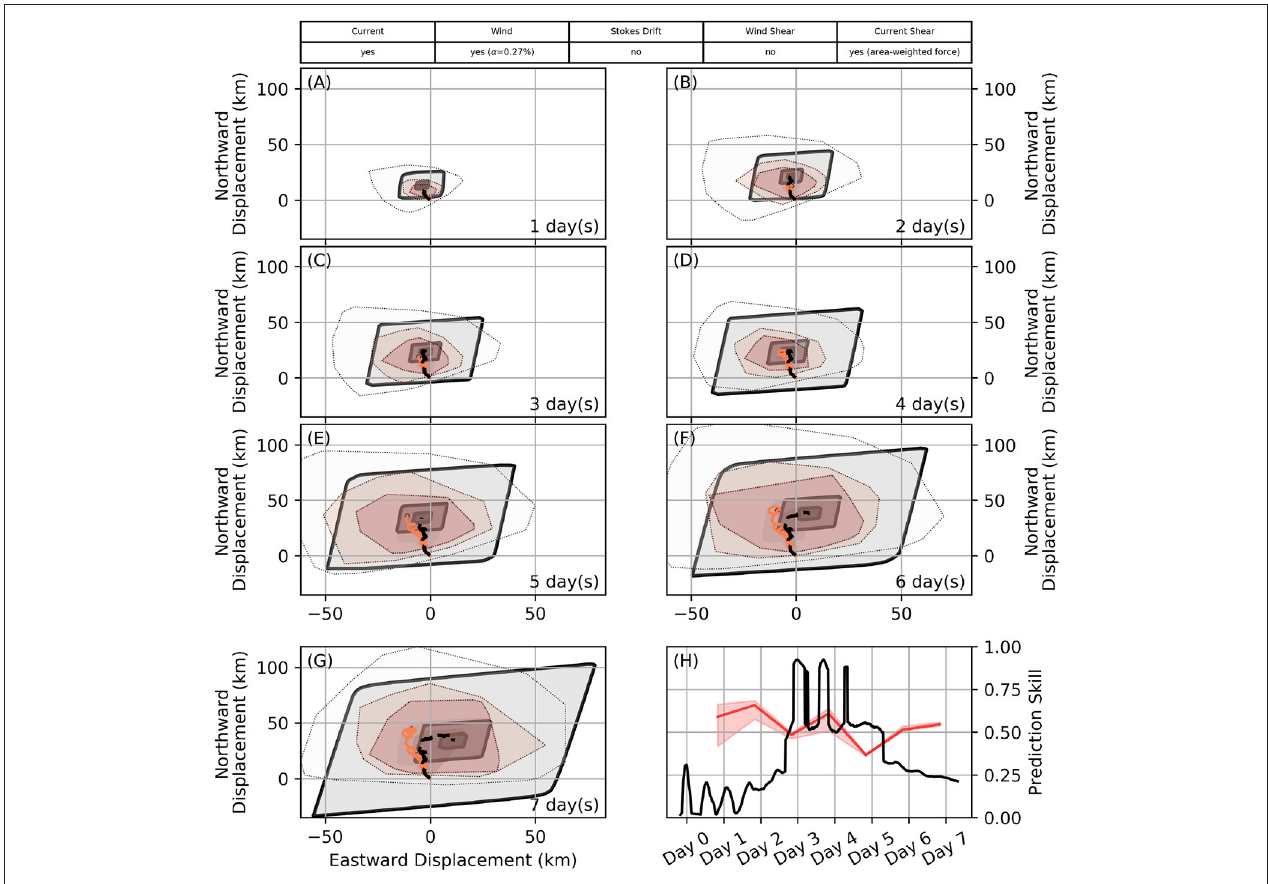
FIGURE 13 | Daily predicted tracks of the SVP 18 drifters for 7 days after deployment using the indicated optimal forcing combination (A–G) , and a time series of model skill during this period (H) . Same layout as Figure 9 .